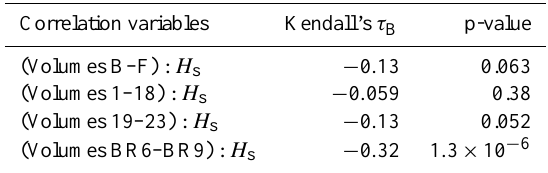
Table 8. Comparison of measured annual erosion